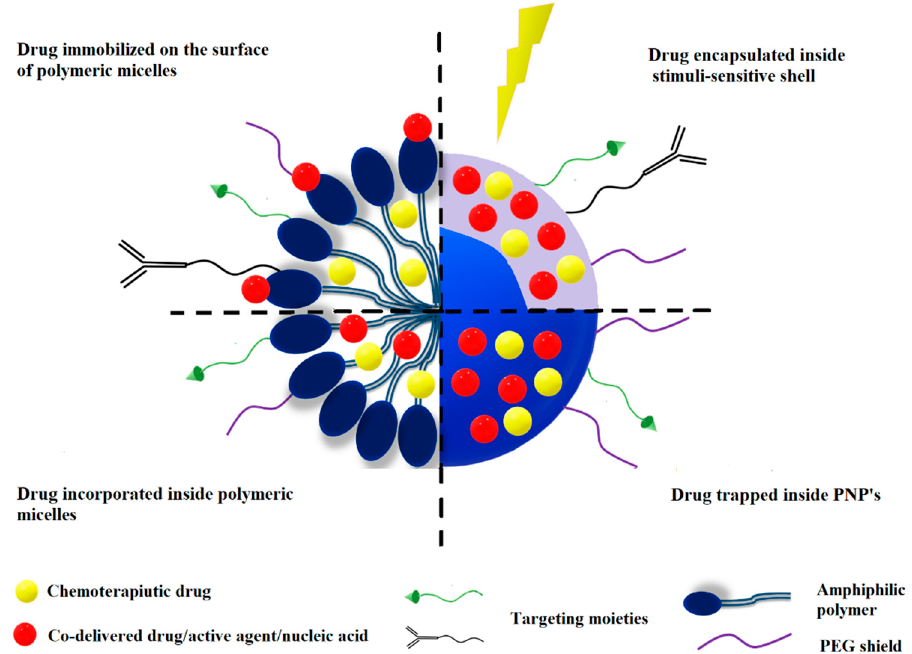
Figure 1. Drug loading in polymeric nanoparticles used as co-delivery systems in cancer treatment.